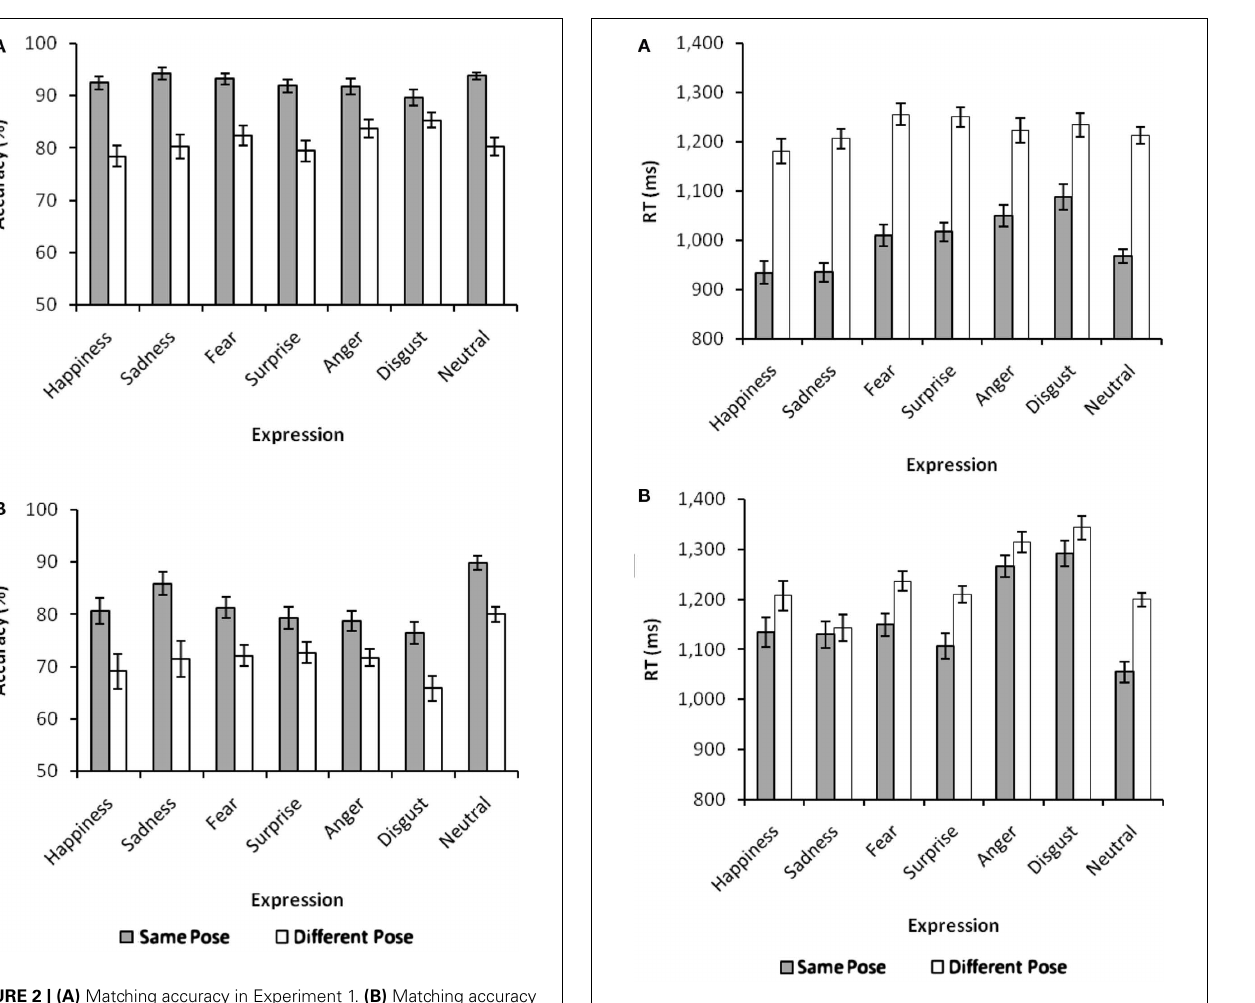
FIGURE 3 | (A) Mean reaction time in Experiment 1. (B) Mean reaction time in Experiment 2. of different poses of the same identity correlated significantly